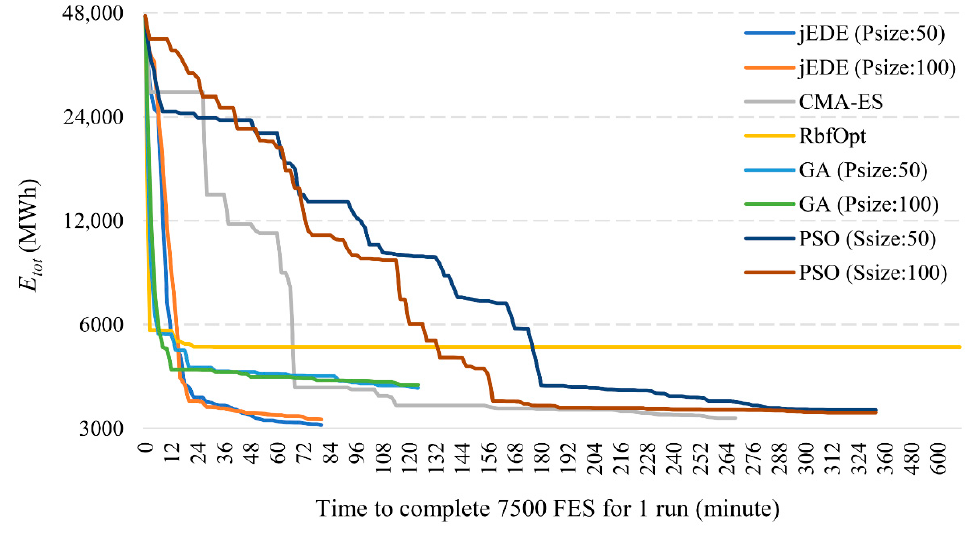
Figure 17. Convergence of the algorithms in time to complete 7500 FES.